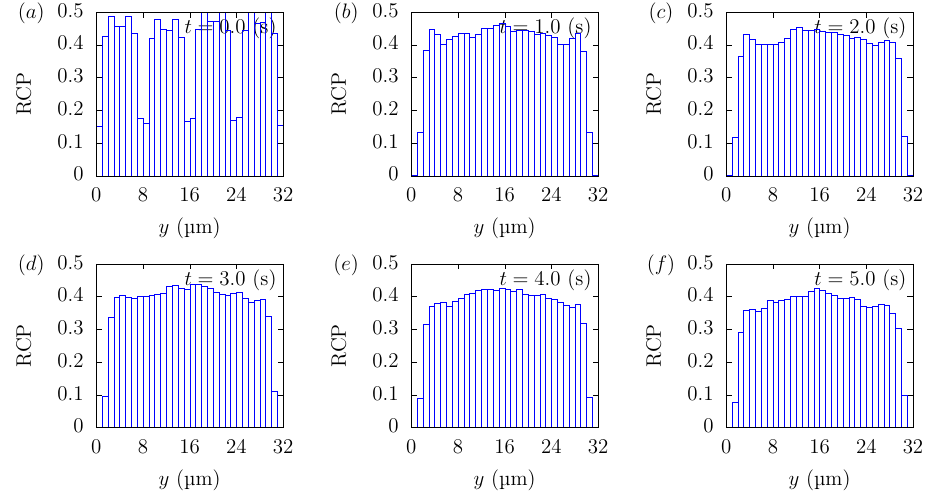
Figure 11. RBC Concentration Profiles (RCPs) in a straight channel of 224 × 32 × 32 µ m for ˙ γ w = 712 s − 1 , Ht = 40% at ( a ) t = 0, ( b ) t = 1.0, ( c ) t = 2.0, ( d ) t = 3.0, ( e ) t = 4.0, and ( f ) 5.0 s. Each graph corresponds to the results in Figure